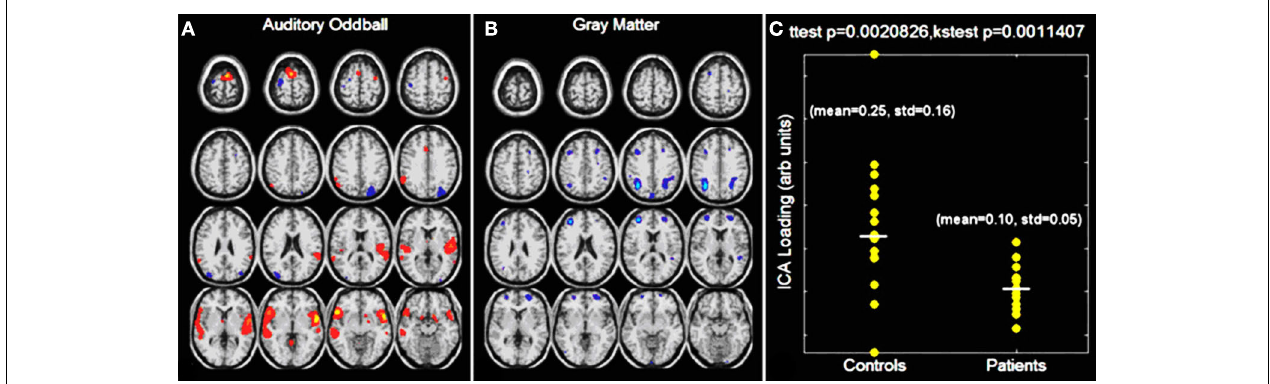
FIGURE 3 |Auditory oddball/gray matter jICA analysis. Only one component demonstrated a significant difference between patients and controls.The joint source map for the auditory oddball fMRI data (A) and gray matter (B) data is presented along with the loading parameters for patients and controls (C)